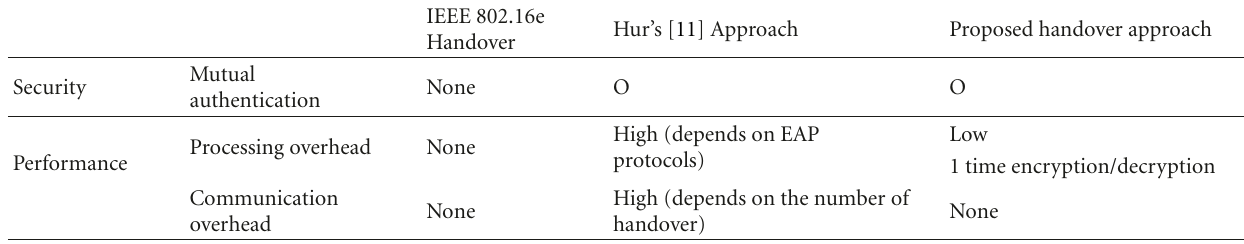
Table 3: Security and performance analysis in handover